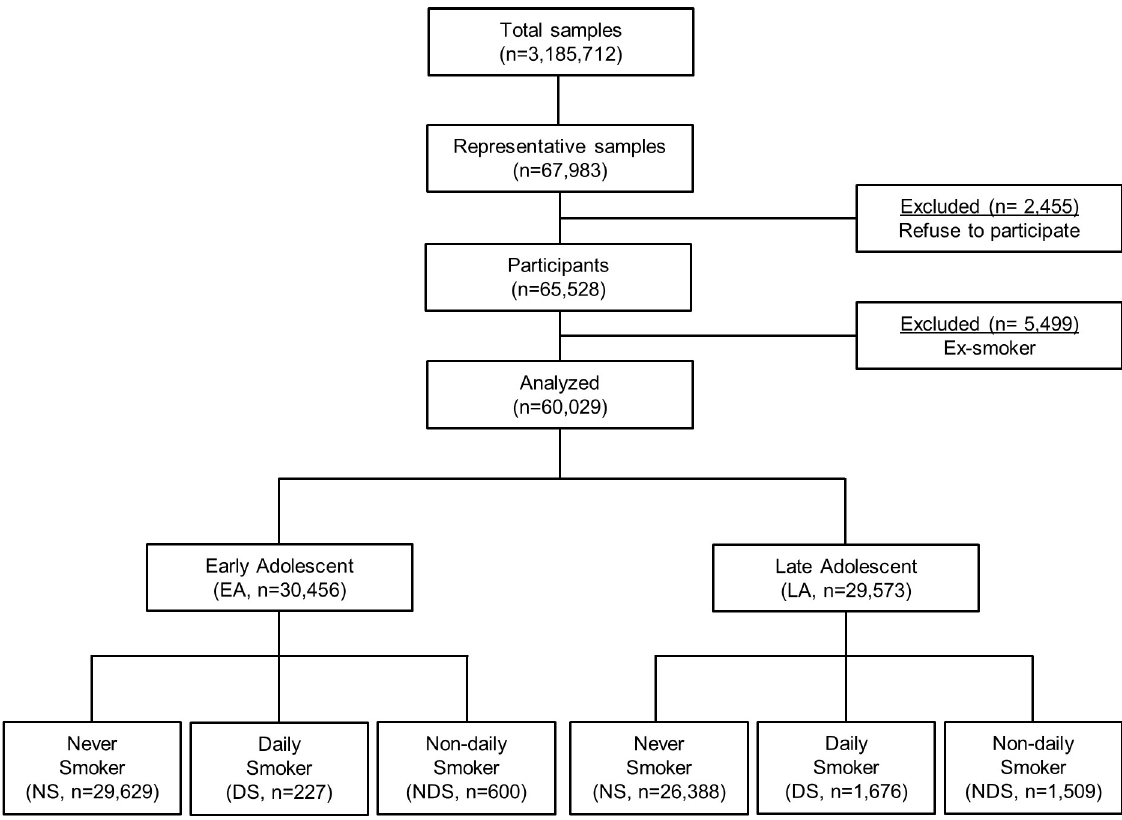
Fig 1. STROBE diagram for the flow of present